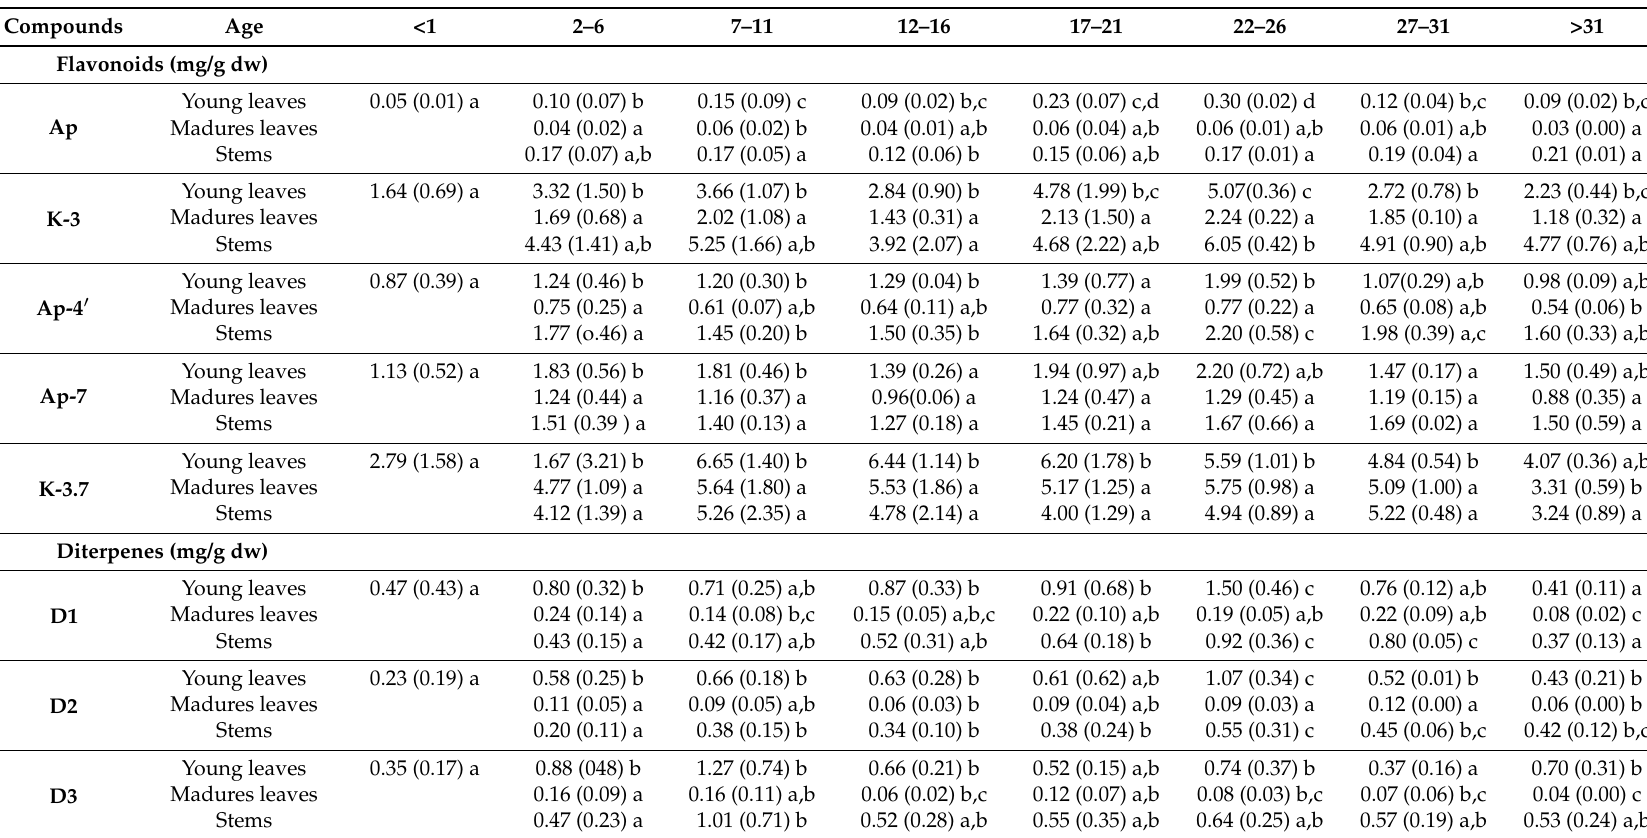
Table 2. Amount of flavonoids and diterpenes (standard deviation) in young leaves, mature leaves and stems of C. ladanifer in individuals of different ages (mg/g dw).